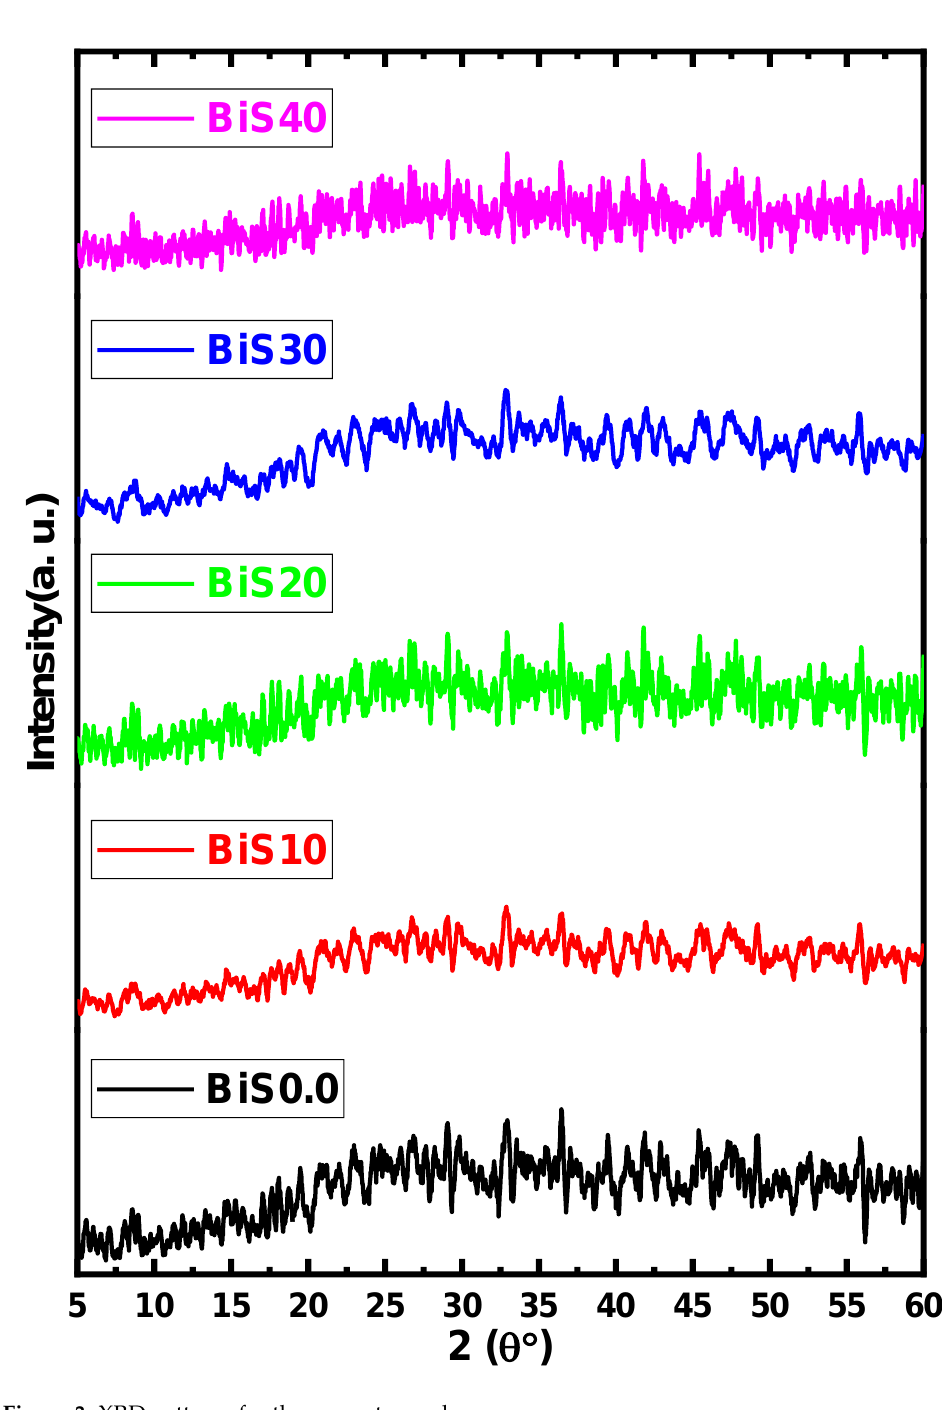
Figure 3. XRD patterns for the present samples.